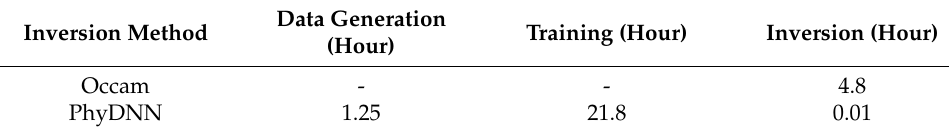
Table 4. Computational loads of the Occam and PhyDNN for inverting the test set.